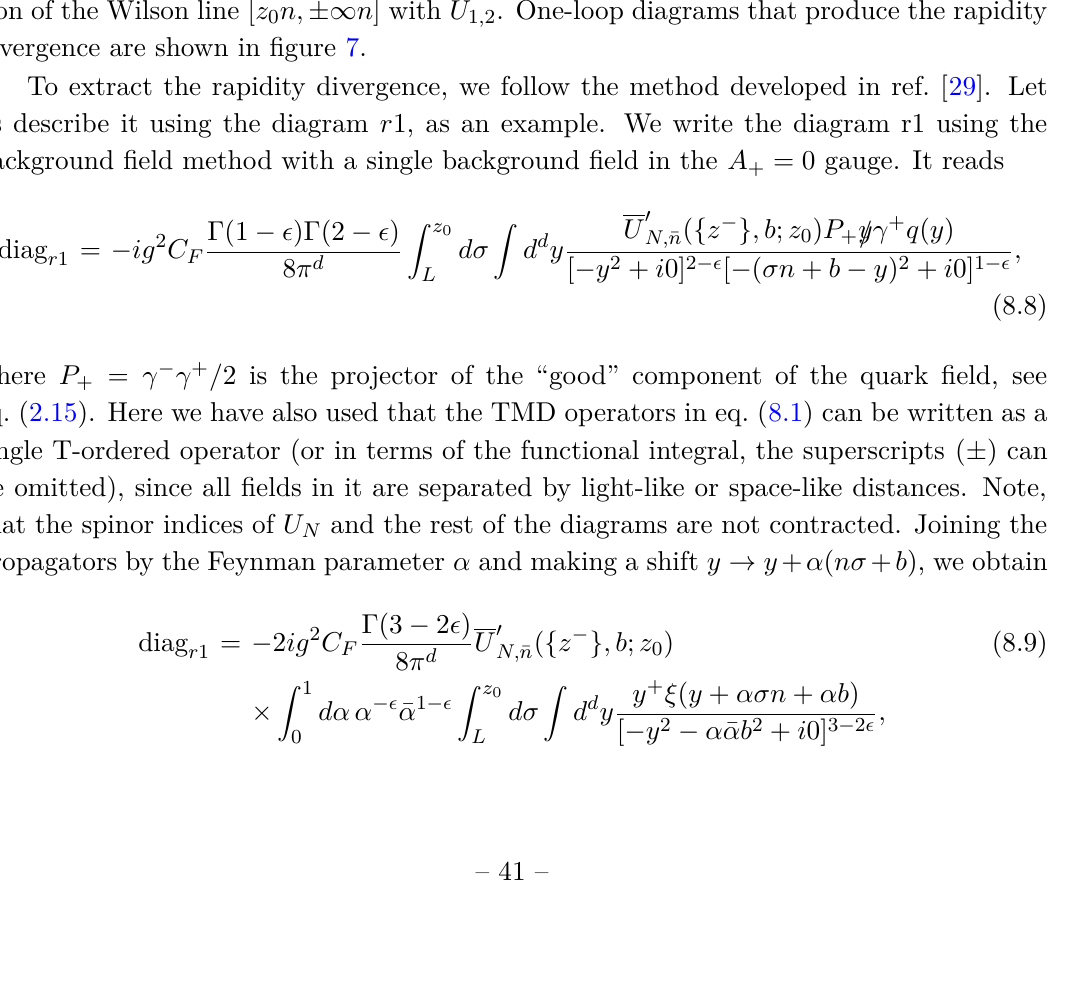
. The dynamical fields are shown in blue. N µ +